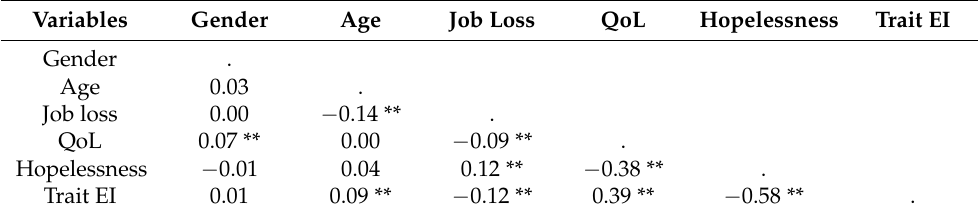
Table 1. Correlations for all study variables.